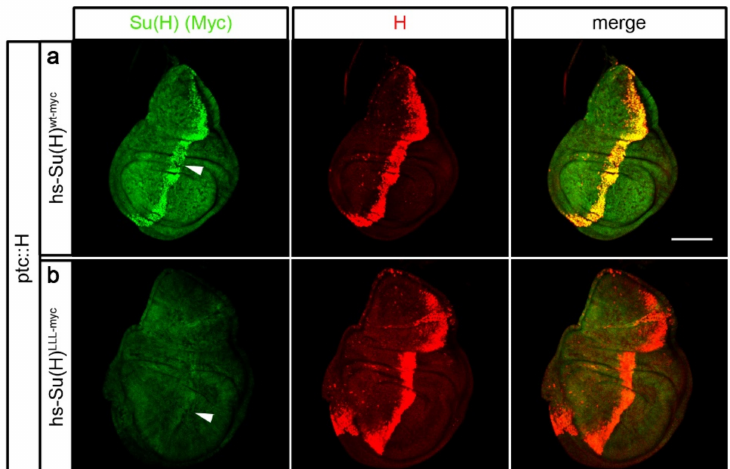
Figure 3. Su(H) protein is protected from degradation by H protein in vivo. ( a ) The local overexpres- sion of H protein (ptc::H) is sufficient to stabilise Su(H) wt-myc protein (arrowhead) induced by a heat pulse. ( b ) In contrast, Su(H) LLL-myc protein disappears over time (arrowhead). Imaginal discs were stained 4 h after Su(H) protein induction specifically with anti-myc antibodies (green), and for H protein (red), respectively. Size bar, 100 µ m. Genotypes are: ptc-Gal4/+; hs-Su(H) wt-myc /UAS-H ( a ) and ptc-Gal4/+; hs-Su(H) LLL-myc /UAS-H ( b